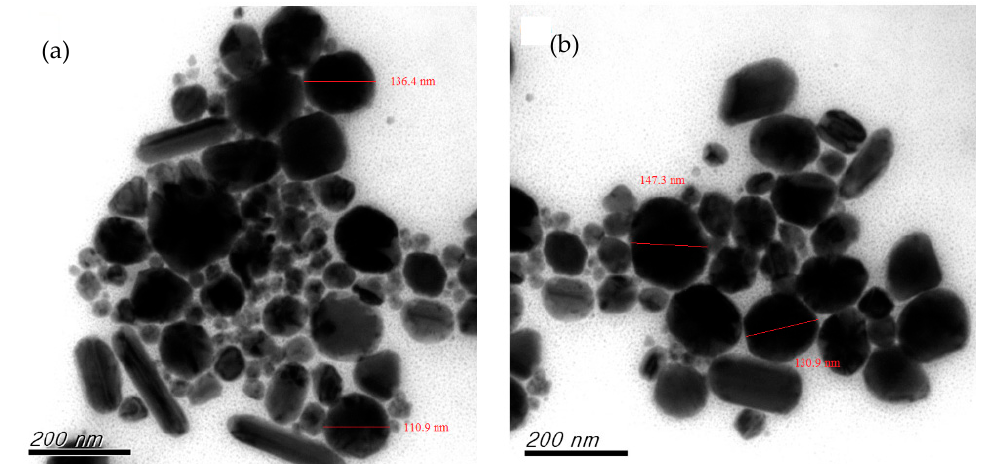
Figure 4. Primary reduction when (AA)/(CuSO 4 ) = 20: ( a ) pH = 10.5; ( b ) pH = 11.